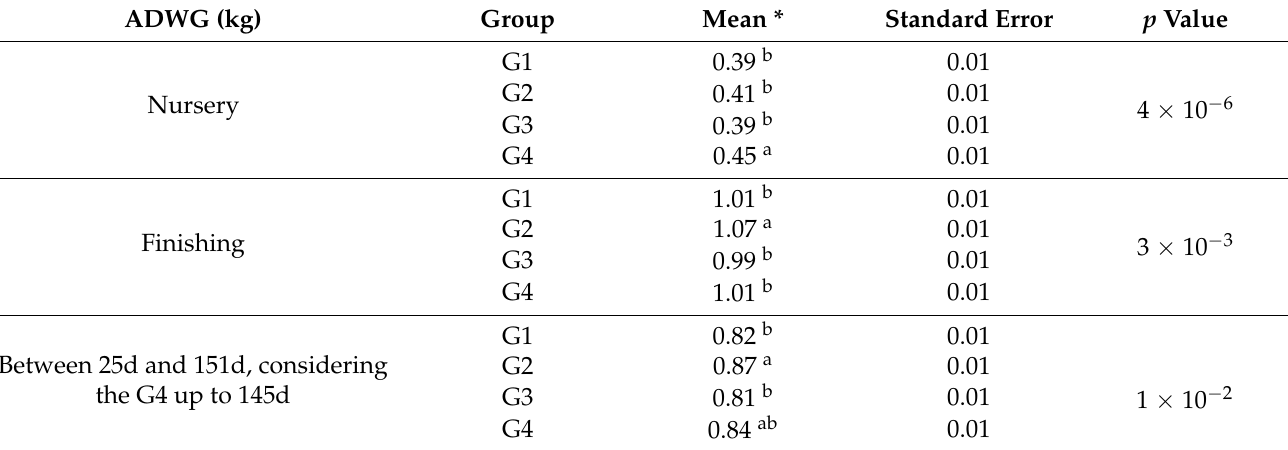
Table 3. Average daily weight gain (ADWG) of the four groups in the nursery, finishing phase, and weaning to slaughter phase.